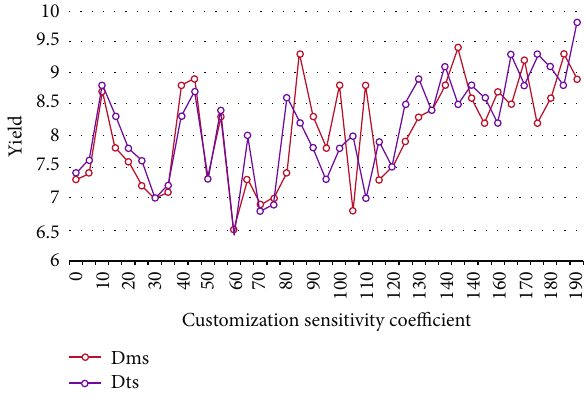
Figure 9: Distribution center location optimization